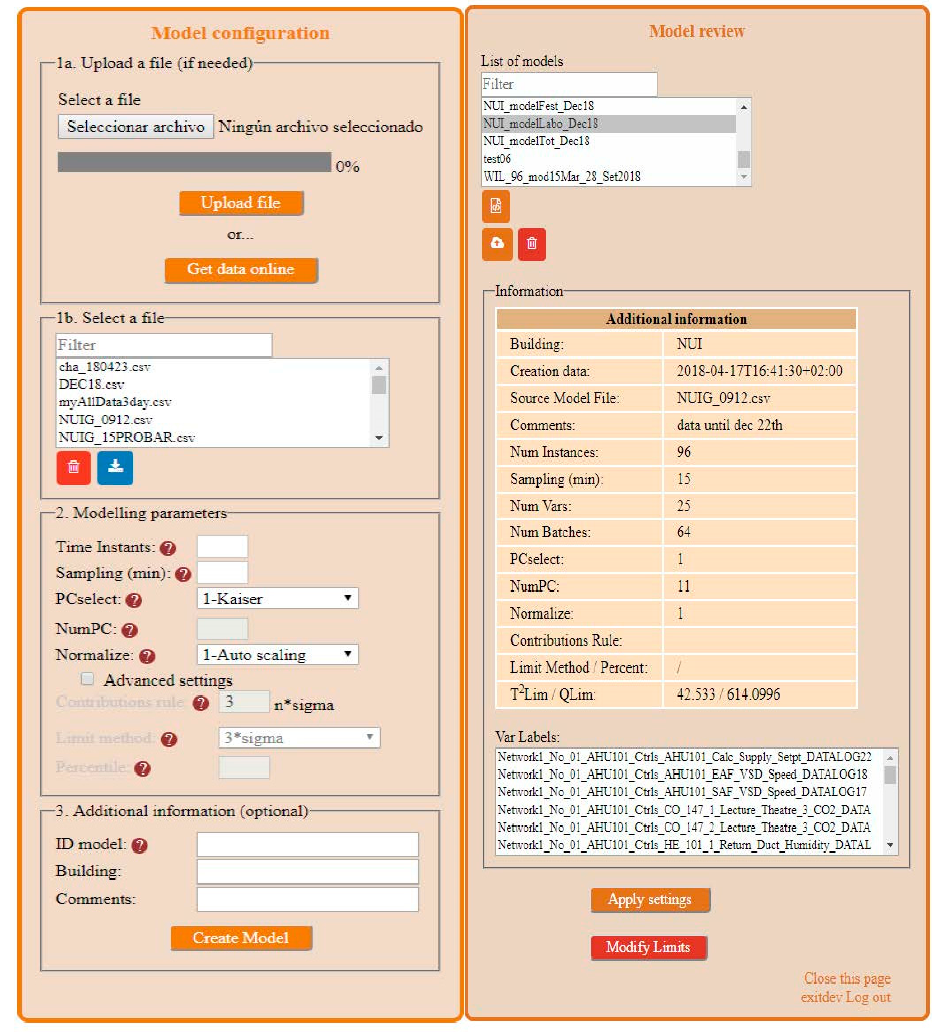
Figure 2. Modelling interface.